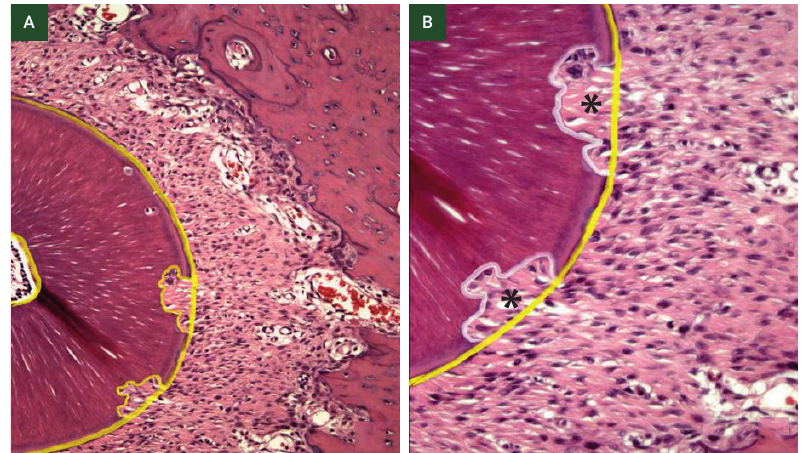
Figure 4. Cross section of distobuccal root (DV) with 7 days of orthodontic movement. A - Section area of the root, including cementum and dentin (Staining - HE, Lens - 4x). B - * Root resorption area (Staining - HE,